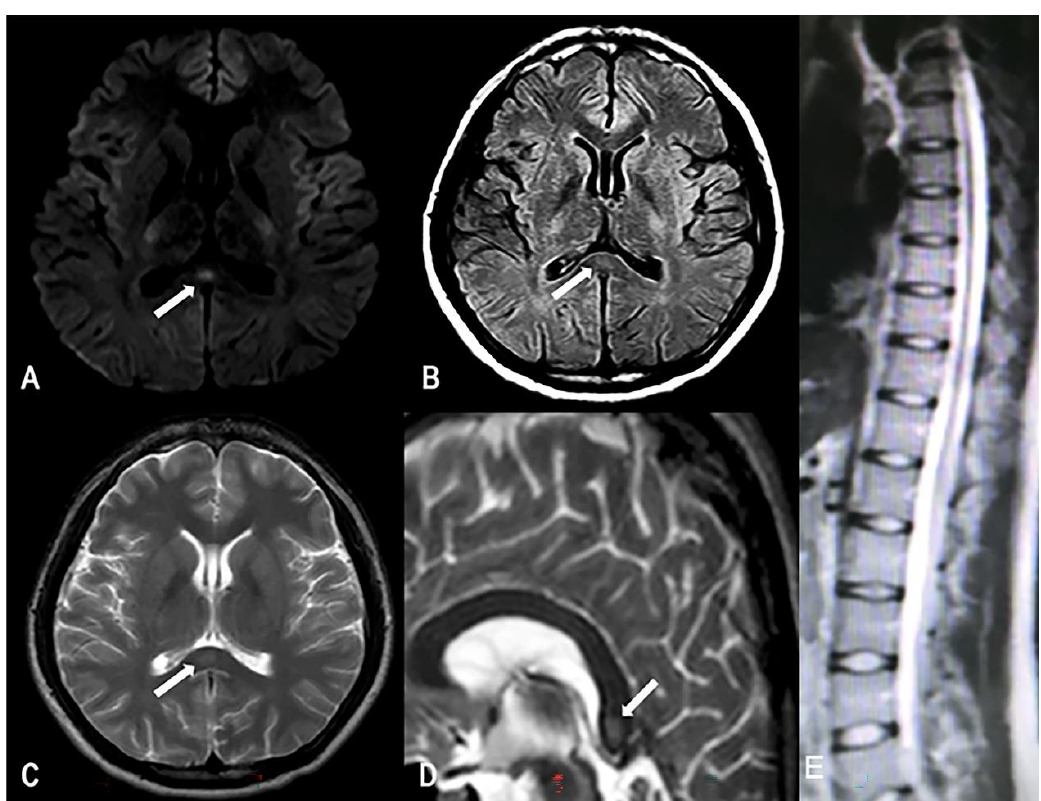
Figure 1. MRI demonstrating the splenial lesion. ( A ) Axial fluid-attenuated inversion recovery (FLAIR); ( B ) axial diffusion-weighted imaging (DWI); ( C ) axial T2-weighted image; ( D ) sagittal T2-weighted image; ( E ) a normal spinal cord.